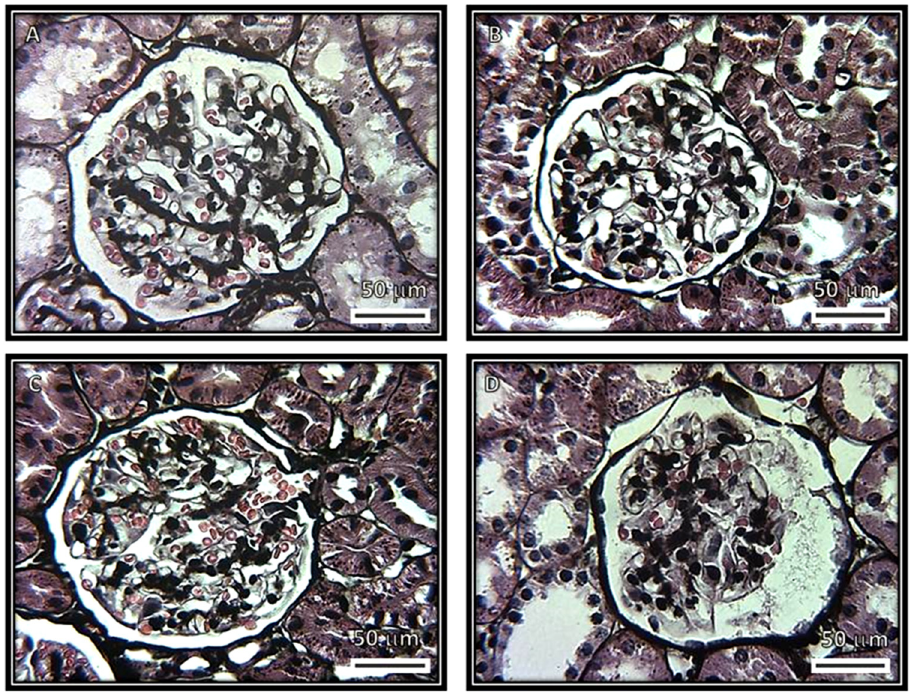
control, ( B ) kidneys from rats injected with saline solution and ( C ) rats that received serum from